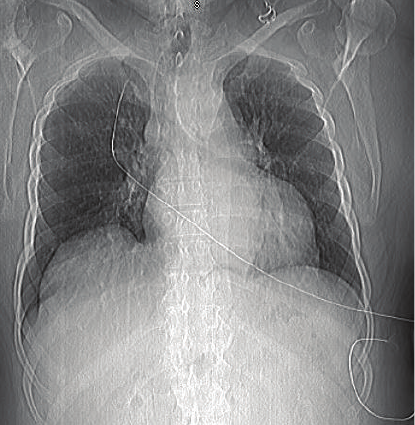
Figure 2: Chest X-ray showing prominence of thoracic aorta, no acute pulmonary